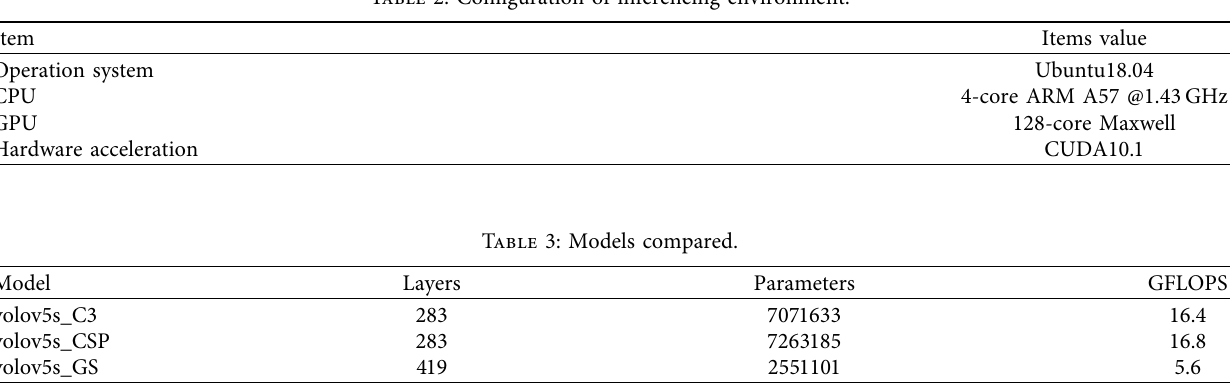
Table 2: Configuration of inferencing environment.